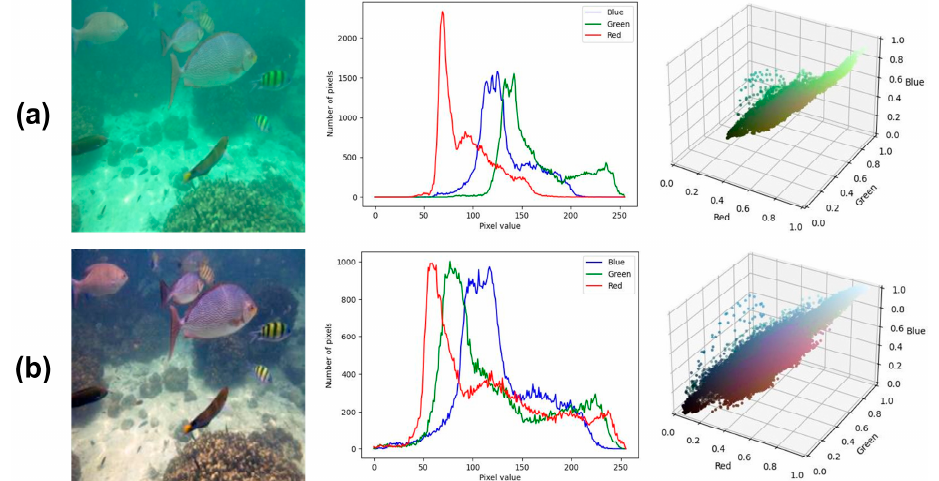
Figure 1. An example of the color distribution of an underwater raw image and its corresponding enhanced image: ( a ) raw image and its tricolor histogram and three-dimensional color distribution; ( b ) enhanced image and its tricolor histogram and three-dimensional color distribution.